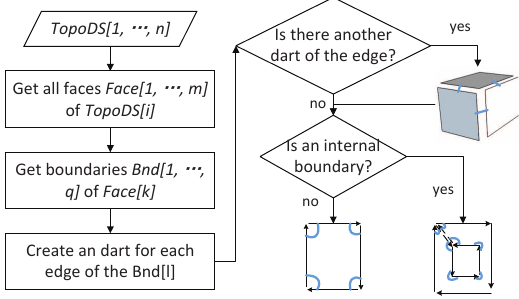
Figure 6. Create isolated 3-cells from